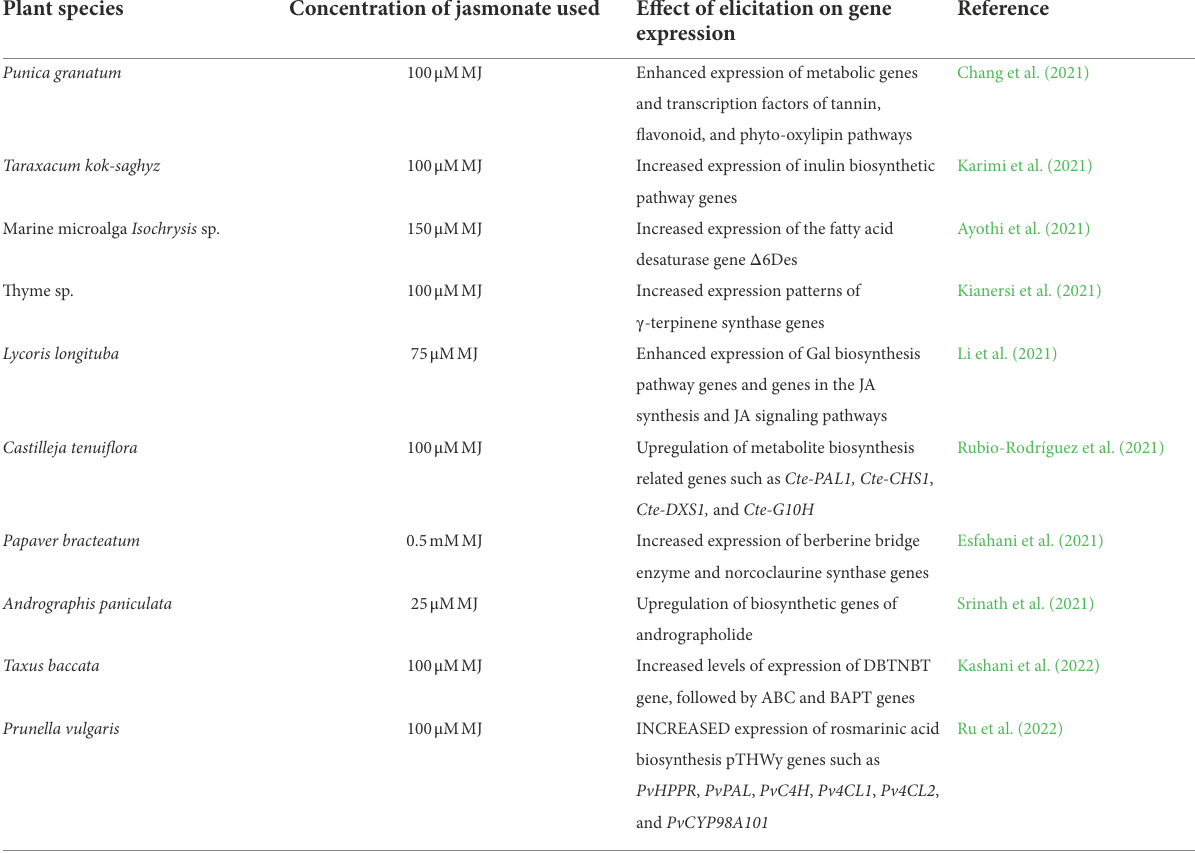
TABLE 2 Reports on influence of jasmonates on gene expression during elicitation of secondary